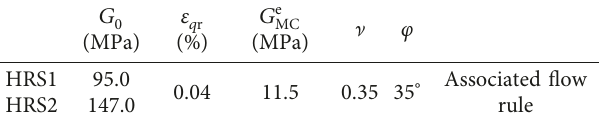
Figure 8: Variation of secant shear modulus in Ham River sand based on data from Jardine et al. [2]. Table 2: Parameters of Mohr–Coulomb and enhanced Mohr– Coulomb